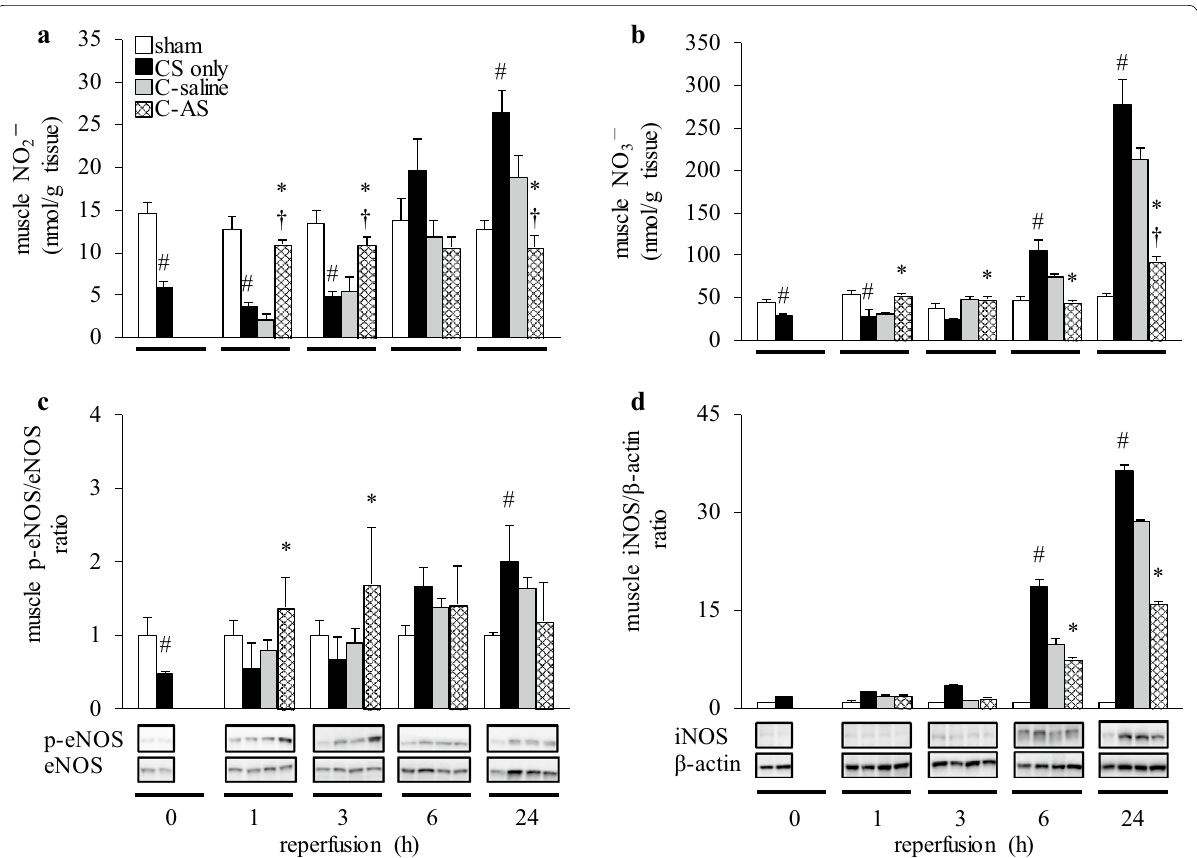
Fig. 4 Effect of fluid resuscitation on NO mechanism in CS rats. a Muscle NO 2 − , b muscle NO 3 − , c muscle p-eNOS/eNOS ratio, and d muscle iNOS/β-actin ratio. White bar sham, black bar CS-only, gray bar C-saline, and shaded bar C-AS. Values represent mean sham group, * p < 0.05 versus CS-only group, and † p < 0.05 versus C-saline group (Tukey’s test). CS crush syndrome, NO nitric oxide, eNOS endothelial nitric oxide synthase, iNOS inducible nitric oxide